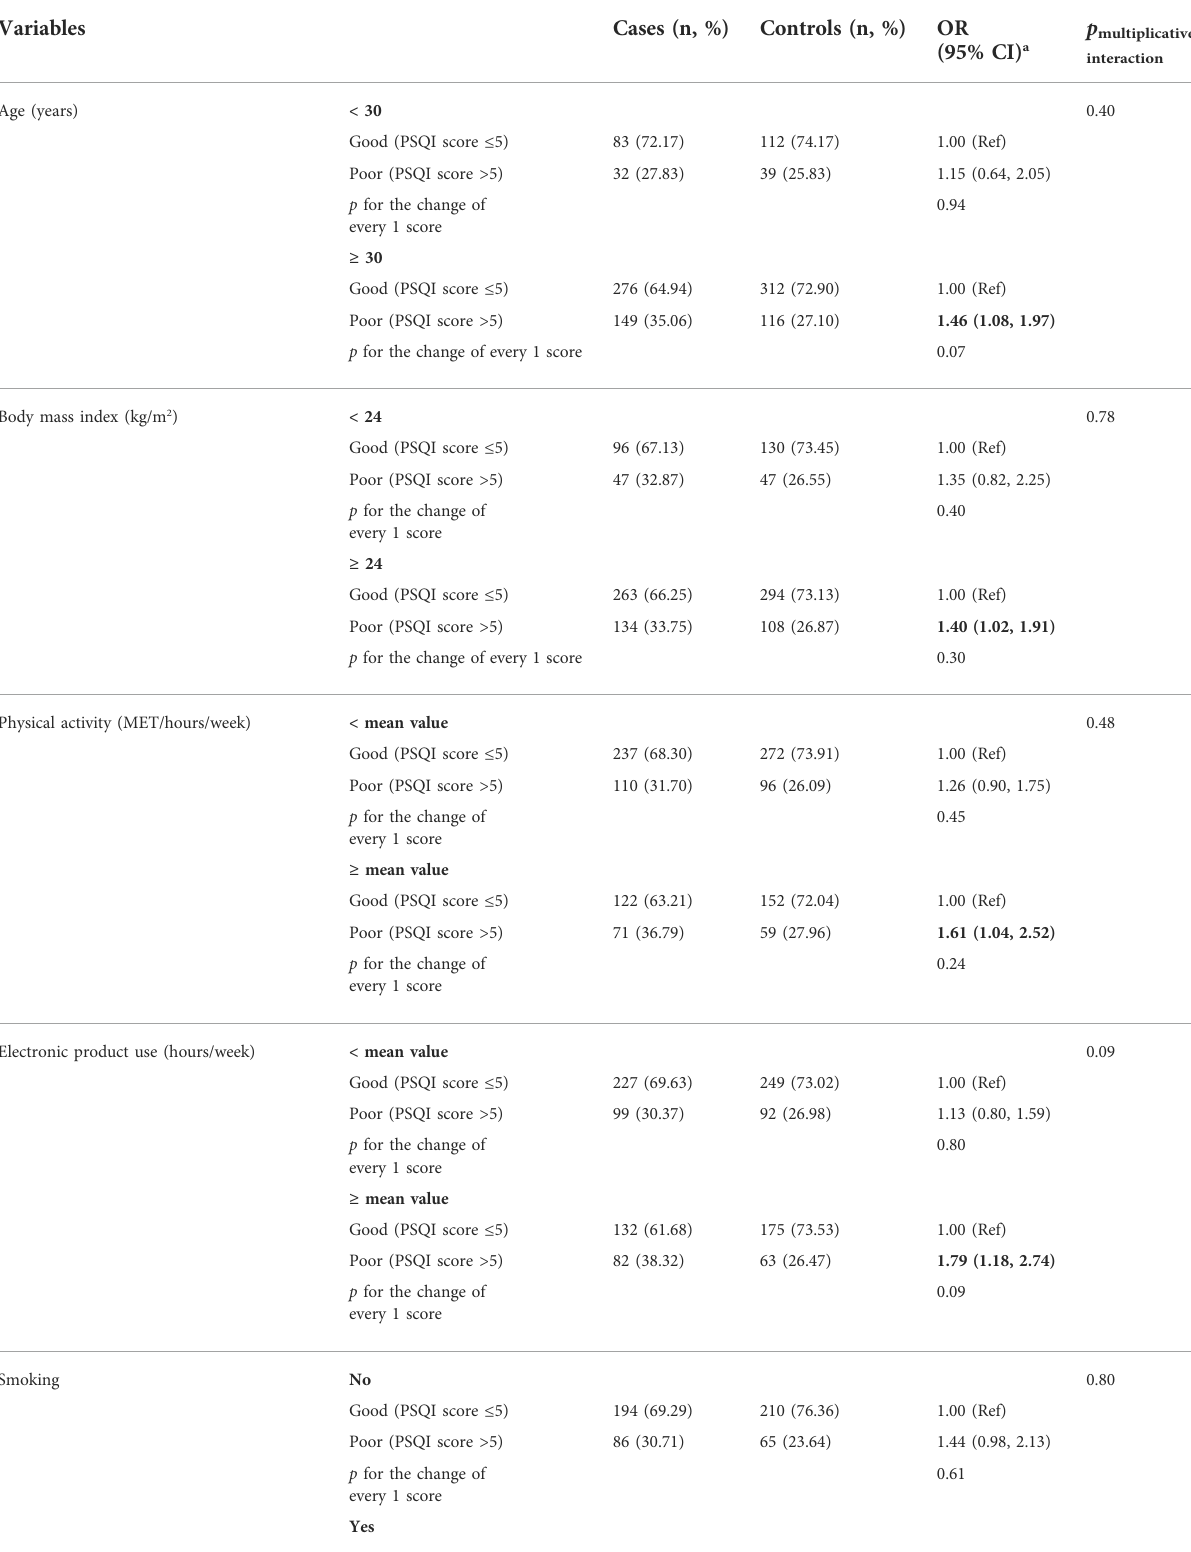
TABLE 3 Subgroup analyses of the associations between sleep quality and asthenozoospermia